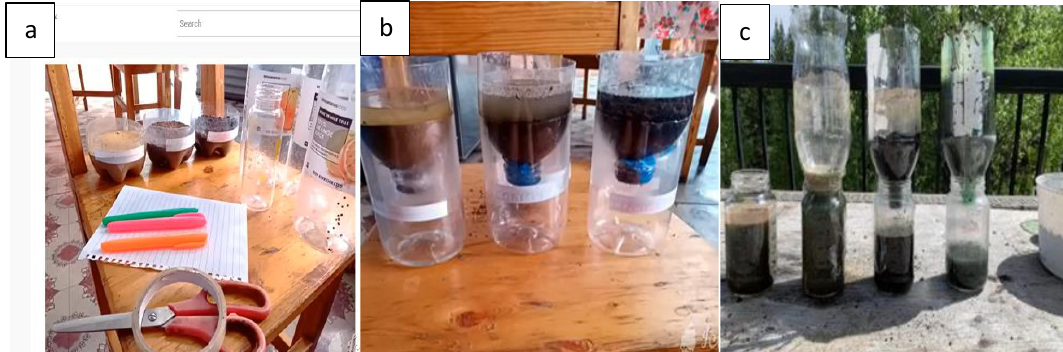
Figure 1. Group 1 experiment: investigating the water-holding capacity of soils